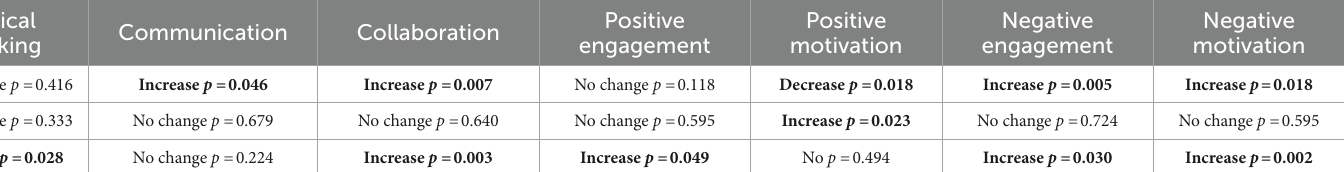
TABLE 3 Intake 1 quantitative changes over time (significant changes at p < 0.05 level in